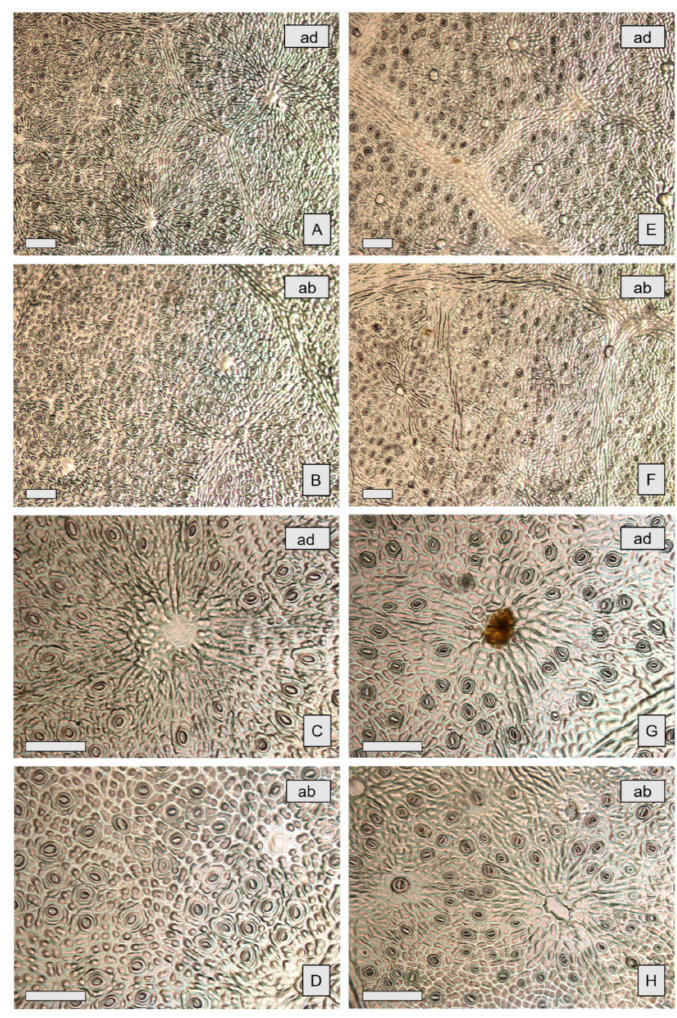
Figure 3. LM— A – D : E. gunnii (EG); E – H : E. pulverulenta ‘Baby blue’ (EP). Comparison between leaf peelings from abaxial (ab) and adaxial surfaces (ad), at different magnifications. EG: adaxial surface at 10 × ( A ) and at 20 × ( C ); abaxial surface at 10 × ( B ) and at 20 × ( D ). EP: adaxial surface at 10 × ( E ) and at 20 × ( G ); abaxial surface at 10 × ( F ) and at 20 × ( H ). Scale bars: A–H = 100 µ